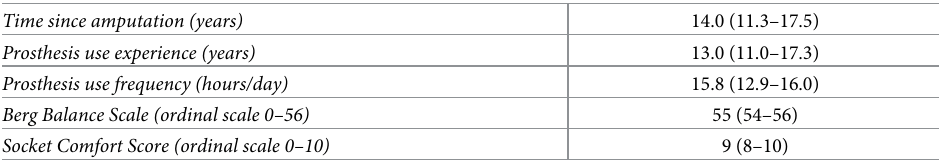
Table 1. BKPU participant characteristics (Median (interquartile range))